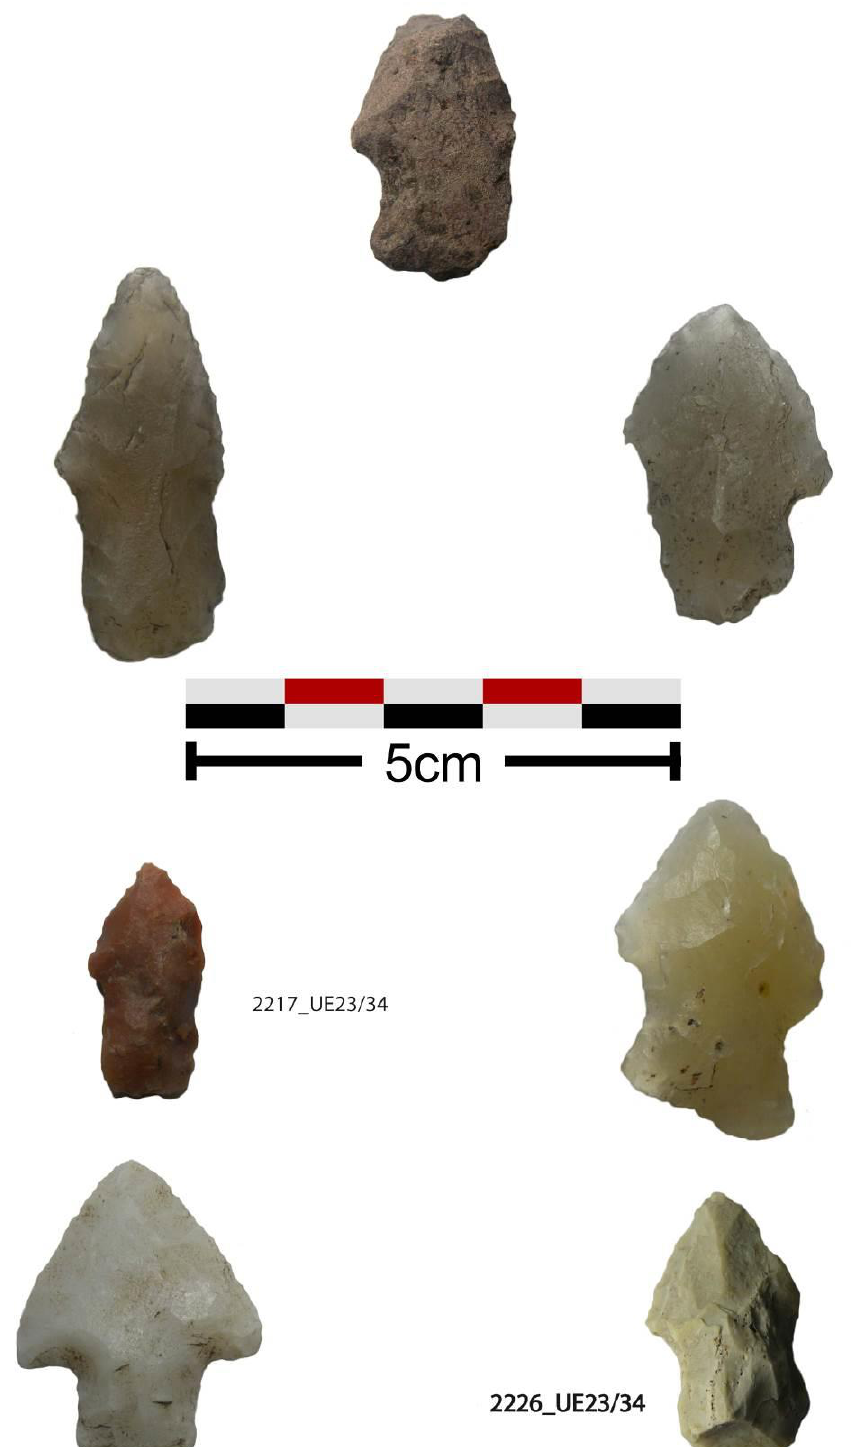
Figure 4. Hafted bifaces recovered from